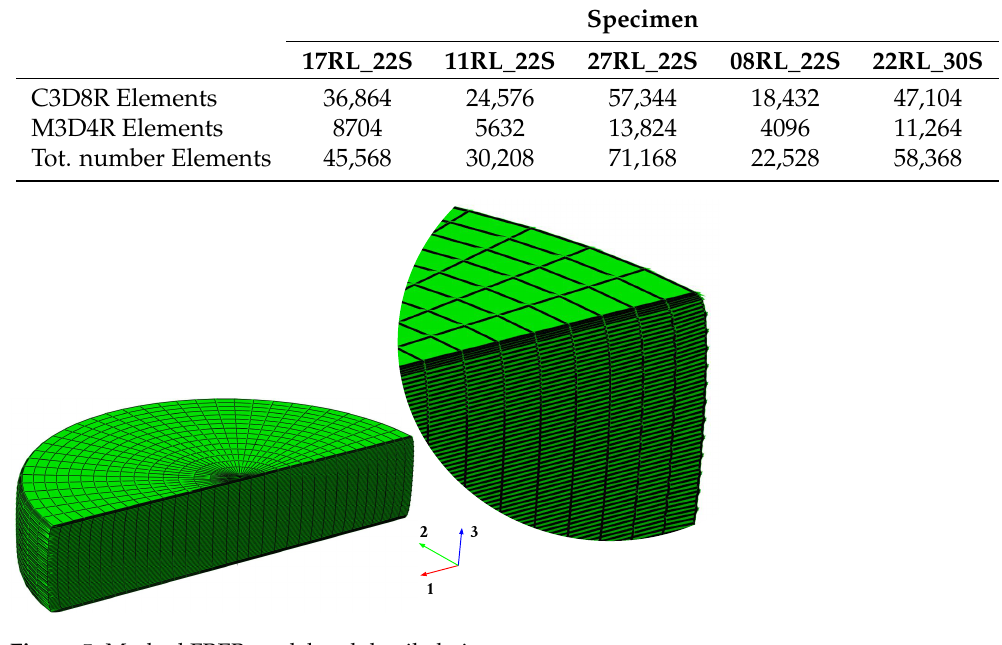
Figure 5. Meshed FREB model and detailed